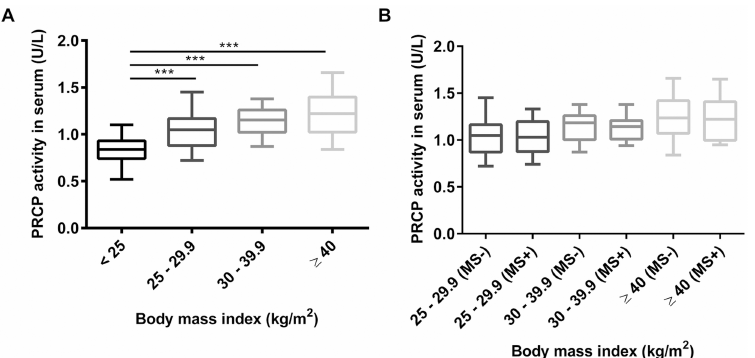
Fig 3. Serum PRCP activity in lean and obese patients. (A) PRCP activity was measured in serum of lean and obese patients categorized based on their BMI and (B) the diagnosis of metabolic syndrome (no (-), yes (+)). ( (cid:3)(cid:3)(cid:3) p < 0.001, n = 10–20 per group).